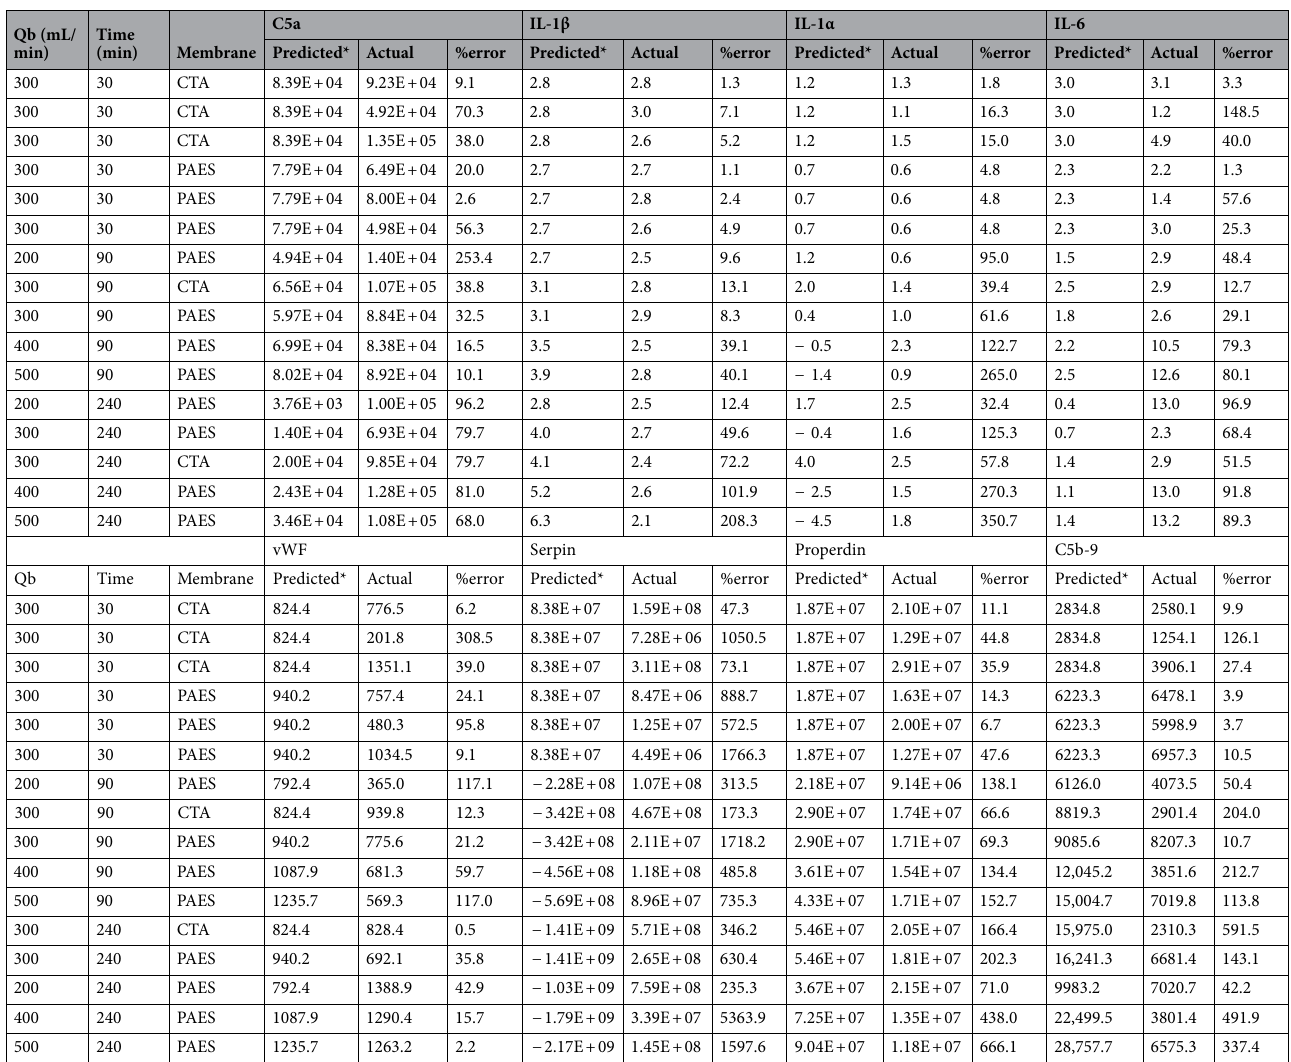
Table 3. Predicted [obtained from Eqs. (41–48), and correction factor from Table 1] and actual values for the concentrations of all biomarkers based on the expanded model for CTA and PAES-PVP membranes. *Predicted values obtained with the affinity-based model (Eqs. 41–48). Similar results are obtained if any of the models are used within the experimental range defined. The responses obtained using different models differ between 0 and 2% on